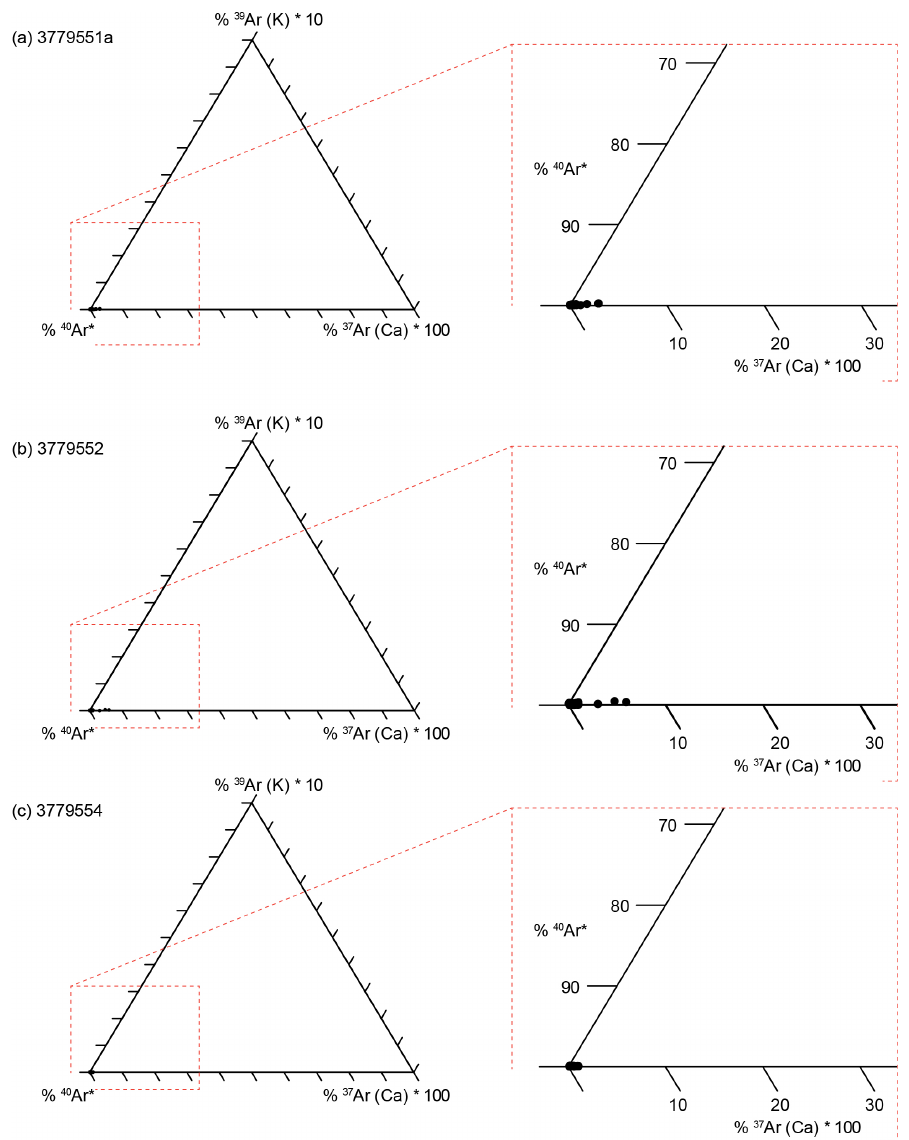
Figure 6. Representative ternary diagram for argon step heating data for three samples from this study: (a) 3779551a, (b) 3779552. and (c) 3779554. These ternary diagrams are based on those presented by Popov et al. (2019) and plot percentages of 40 Ar ∗ , K-derived 39 Ar, and Cl-derived 37 Ar, where the 39 Ar(K) value is multiplied by 10 and the 37 Ar(Ca) value is multiplied by 100. These multiplication factors are required to make the individual heating steps visible on the ternary diagram; without these factors the variation in these two values is not visible, being 2 or more orders of magnitude smaller than 40 Ar ∗